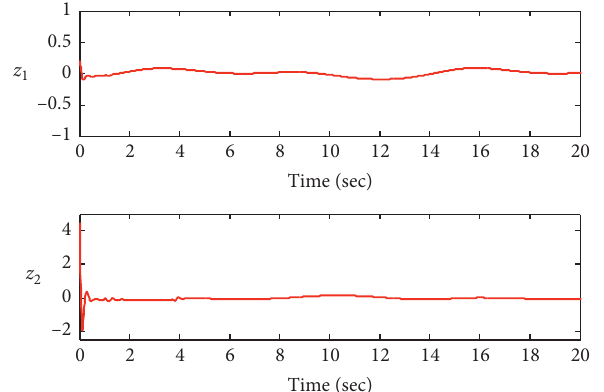
Figure 10: Profiles of the tracking errors z